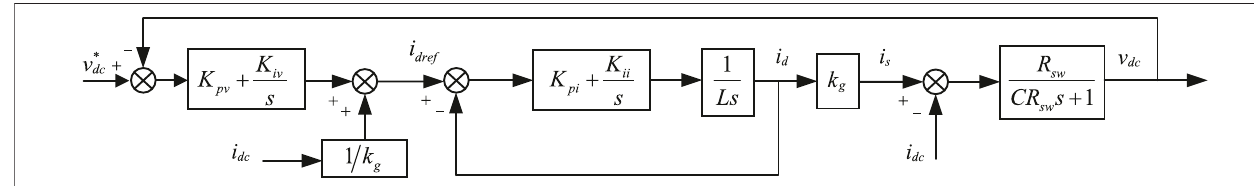
FIGURE 5 | Dual-loop control structure of the inverter.